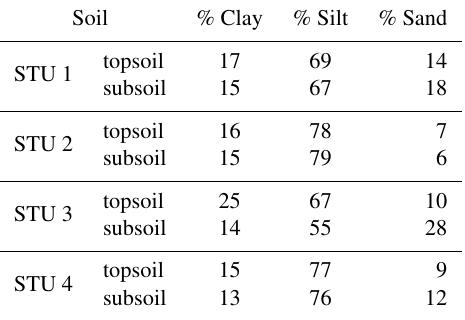
Table 1. Soil texture (median values) of the Schäfertal hillslope site for the topsoil (ca. 0–15cm) and for the subsoil (ca. 15–60cm). More detailed information can be found in Martini et al.